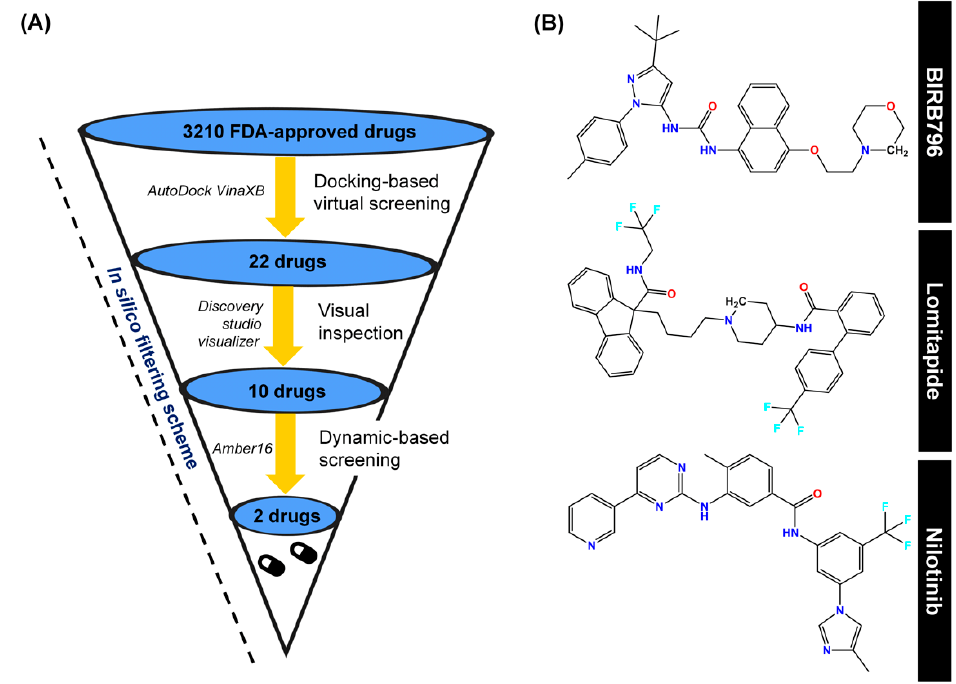
Figure 2. ( A ) In silico filtering scheme, which includes first-round docking-based screening, visual inspection, and SIE-based dynamic screening as well as the program used during each step. ( B ) Chemical structures of a well-known p38 α MAPK allosteric inhibitor (BIRB796), lomitapide and nilotinib, obtained via this computational platform.